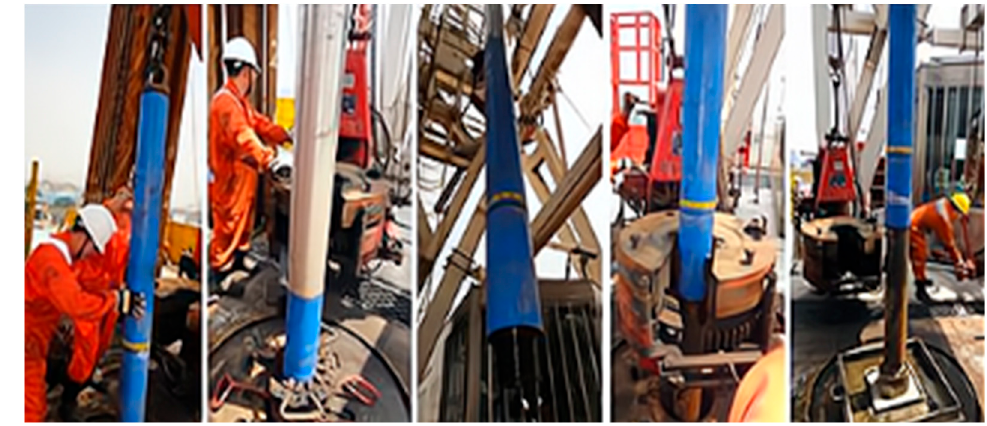
Figure 9. The field of the downhole test.